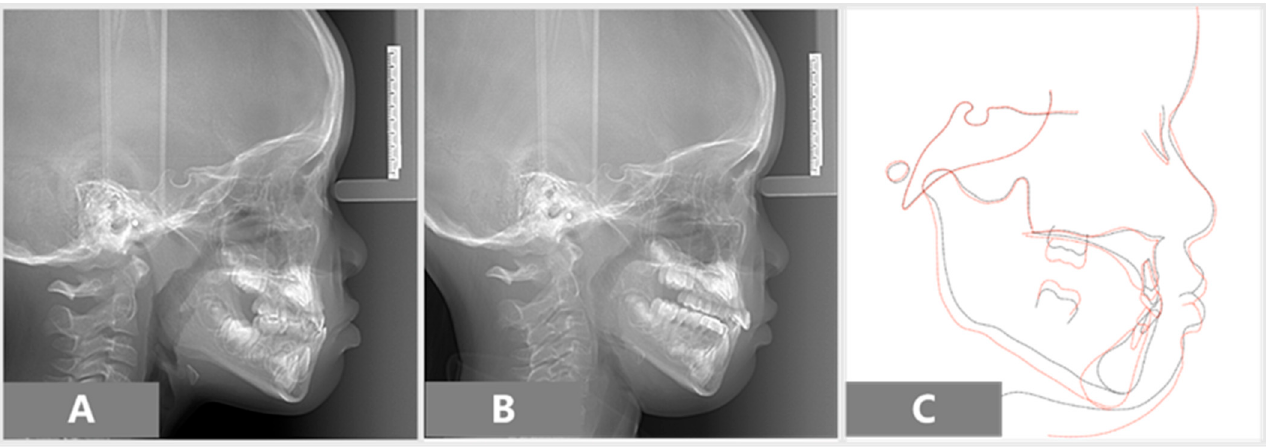
Figure 5. Lateral cephalograms: ( A ) pre ‐ treatment, ( B ) post ‐ treatment, ( C ) superimpositions of pre ‐ treatment (black line) and post ‐ treatment (red line). Table 1. The pre ‐ treatment and post ‐ treatment lateral cephalometric data.